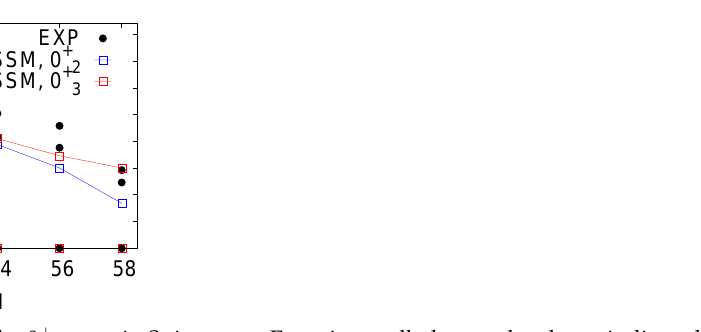
Figure 9. Systematics of the 0 + states in Sr isotopes. Experimentally known levels are indicated in black, while shell model results in red and blue. Lines are added to guide the eye.